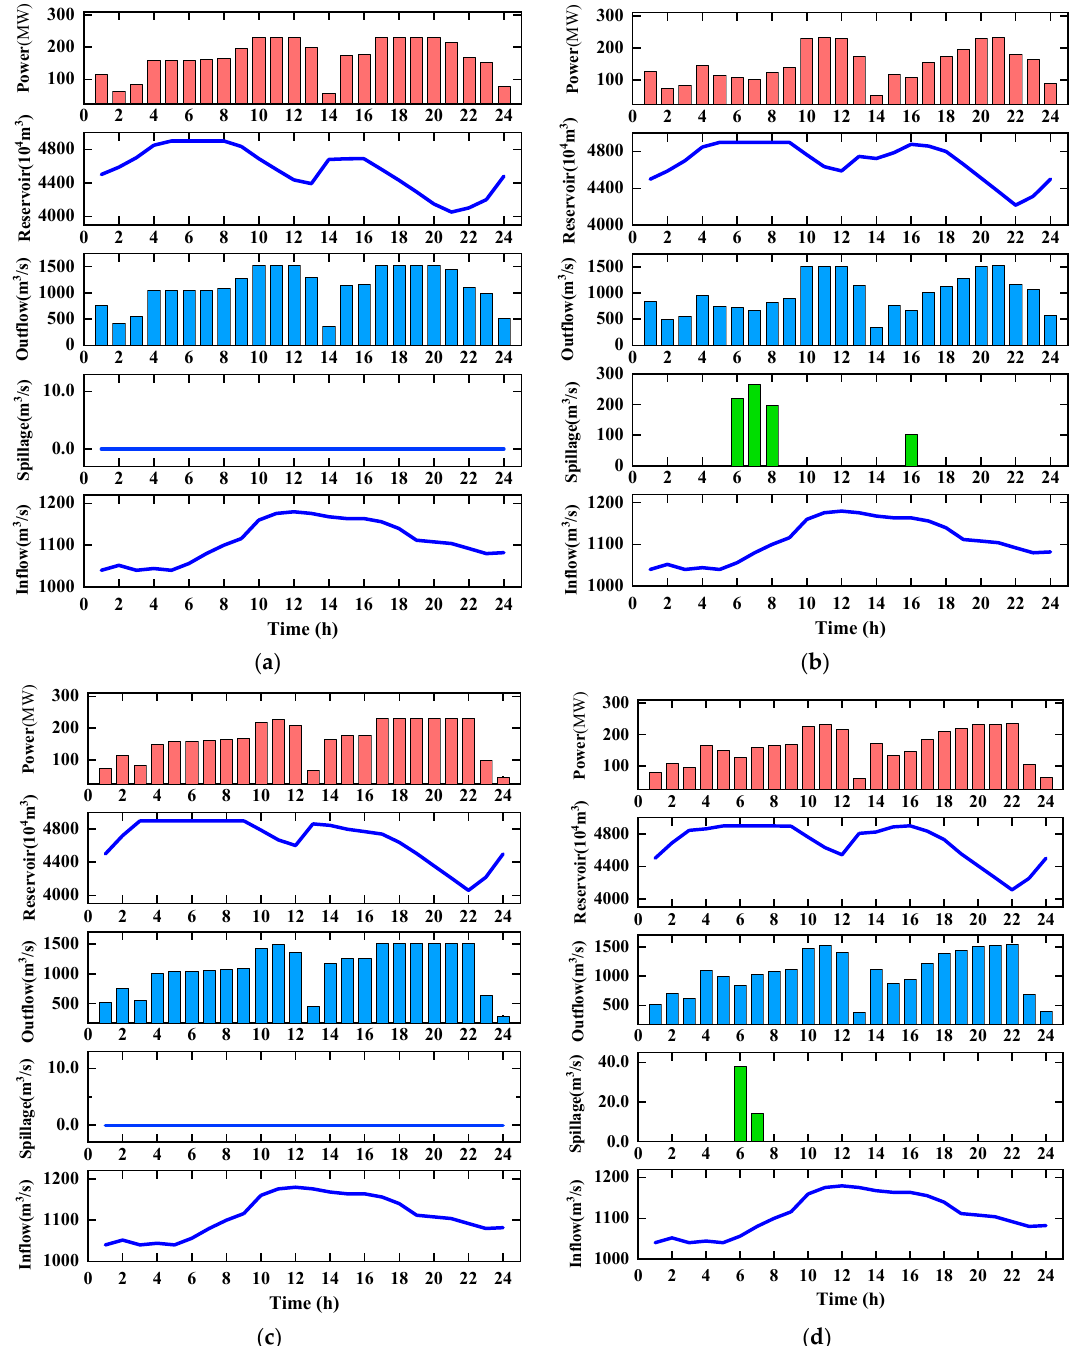
Figure 4. Operation diagram of hydropower plant 1. ( a ) Day-ahead scheduling of TN-DOPF; ( b ) real-time output of TN-DOPF; ( c ) day-ahead scheduling of DR-DOPF; ( d ) real-time output of DR-DOPF.